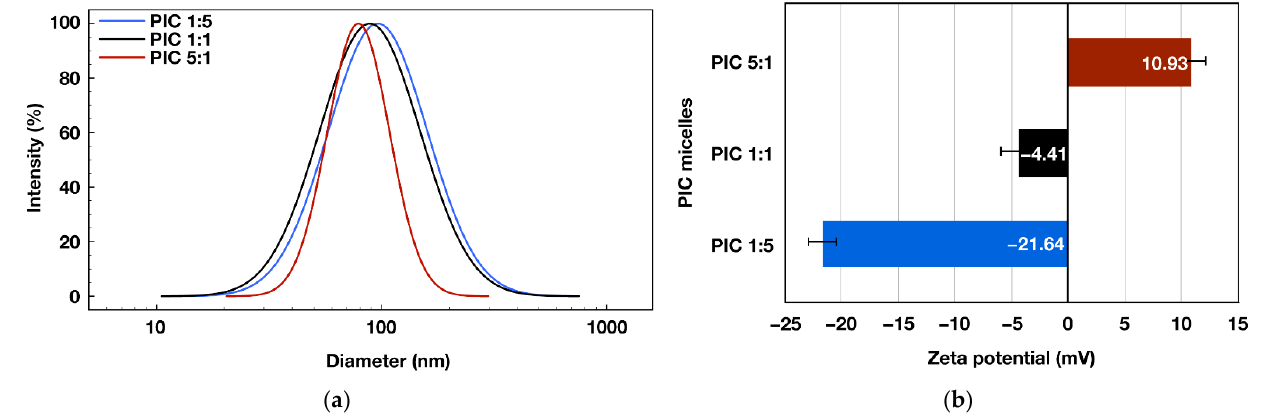
Table 2. Characteristics of polyion complex micelles before and after drug loading.